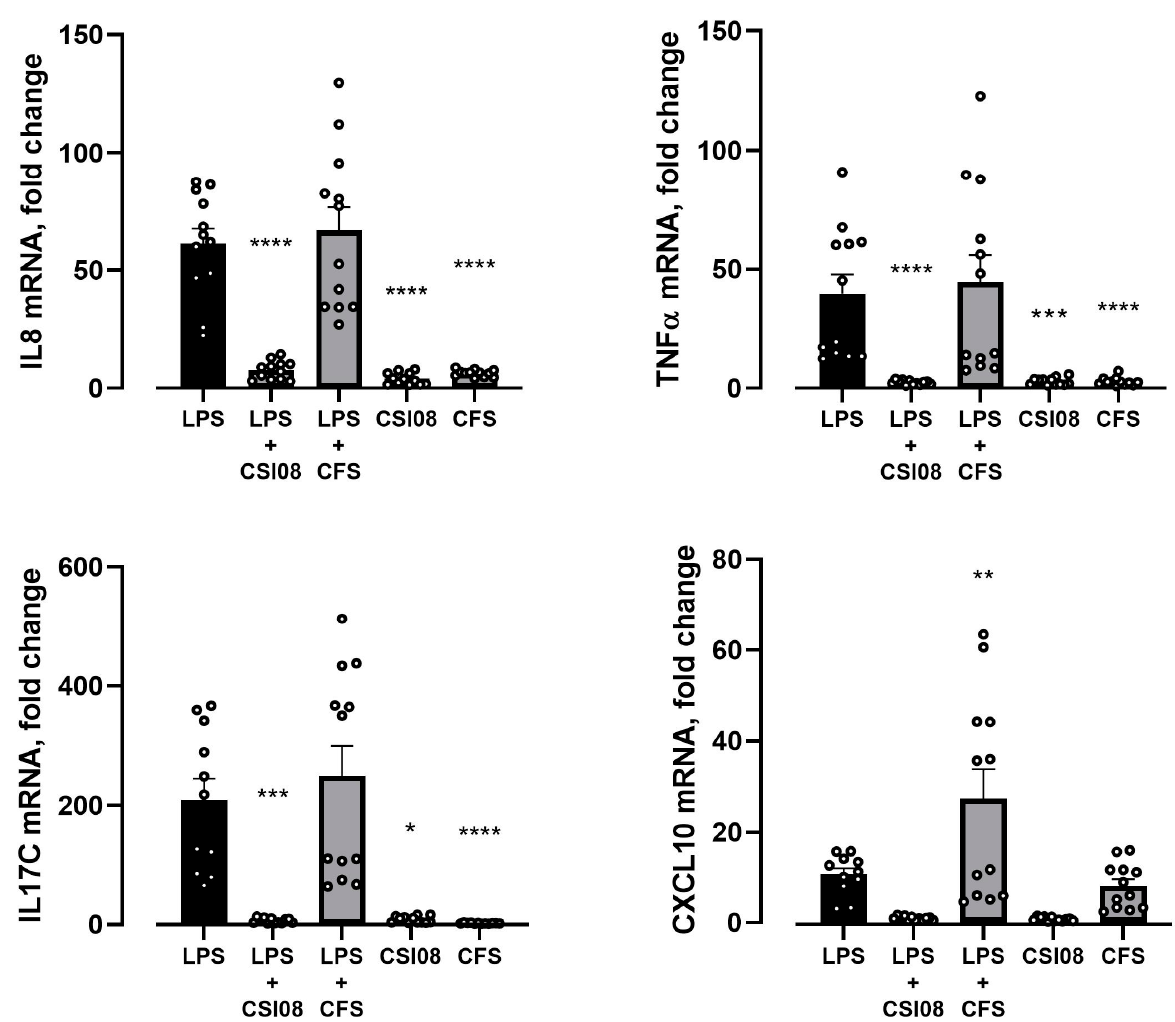
3.2. Immunomodulatory Effect of B. clausii CSI08 in Human Cell Lines The vegetative form of B. clausii CSI08 and its cell-free supernatants were assessed for their ability to modulate pro-inflammatory response in HT-29 cell line, triggered by E. coli lipopolysaccharides (LPS) or Poly I:C, a synthetic double-stranded RNA ligand. Expression level of IL-8, TNF- α , IL-17C, CXCL10 genes have been evaluated at mRNA level using qRT-PCR. As shown in Figure 6, expression of all 4 genes was strongly induced 4 h after stimulation with LPS. Pretreatment with B. clausii CSI08, but not with its cell-free supernatants, greatly inhibited LPS-triggered pro-inflammatory response. Notably, neither the vegetative cells of B. clausii or their supernatants by themselves elicited a significant increase in IL-8, TNF- α , IL-17C, CXCL10 gene expression after co-incubation with HT-29 cells (Figure 6).